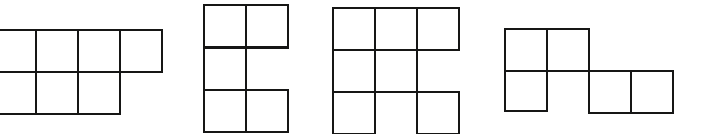
Figure 5. Some shapes generated with training on BCCD (these shapes are not combined with intensity